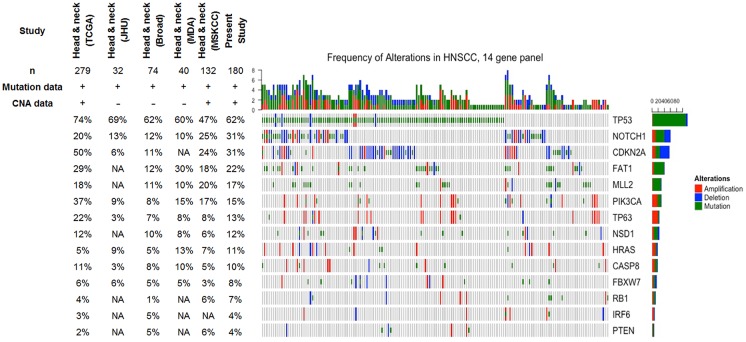
OncoPrint diagram of mutational frequencies and types of alterations of the 14 genes sequenced.Only altered samples are shown. Rows are sorted based on the frequency of the alterations in all samples and columns are sorted to visualize the mutual exclusivity across genes. Frequency of mutations for the following Head and Neck cancer publications are shown: Head & Neck (TCGA)[10], Head & Neck (JHU)[39], Head & Neck (Broad)[32], Head & Neck (MDA)[40], Head & Neck (MSKCC)[41]. NA: Not available.